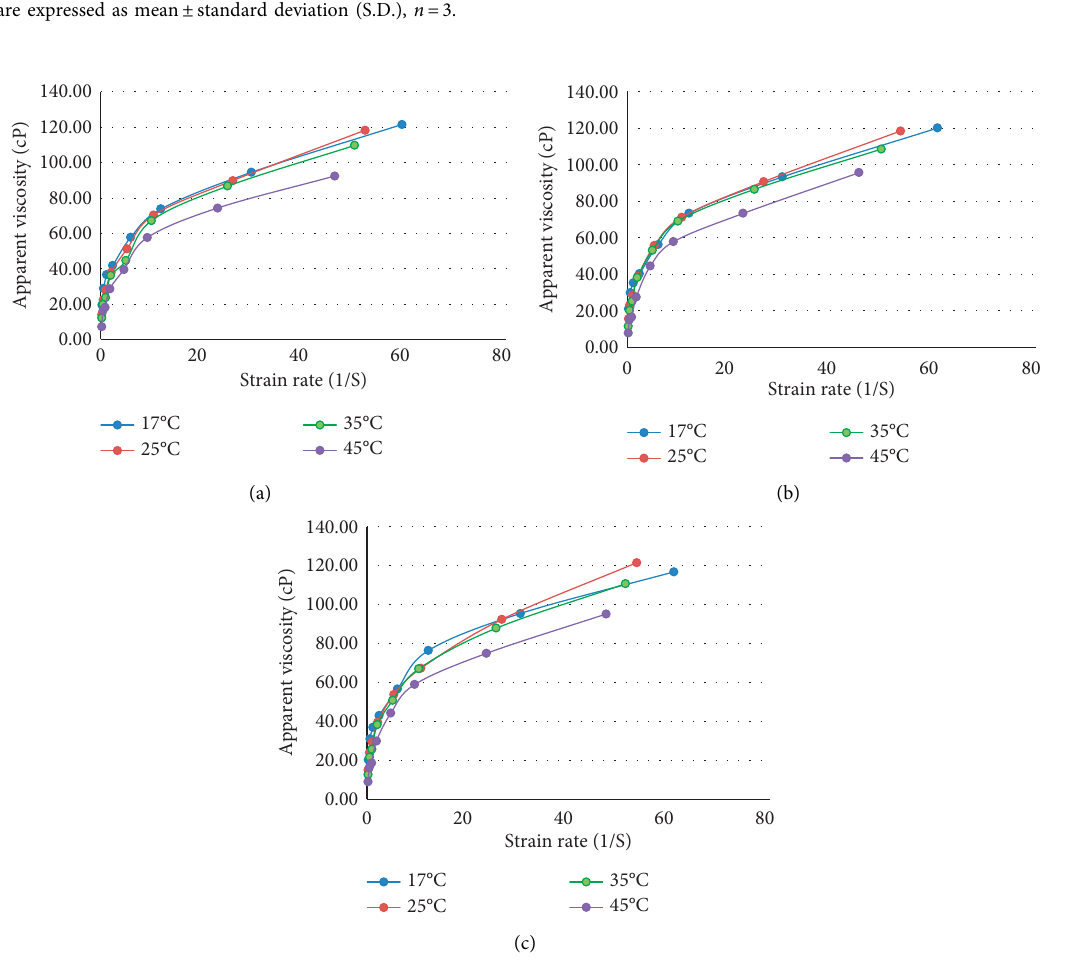
Figure 3: Rheological curves of loquat compote ( Mespilus germanica L.) with 0.20% agar from Chondracanthus chamissoi with three replicates: (a) repeat 1, (b) repeat 2, and (c) repeat 3 at four diferent temperatures (17 ° C, 25 ° C, 35 ° C, and 45 °